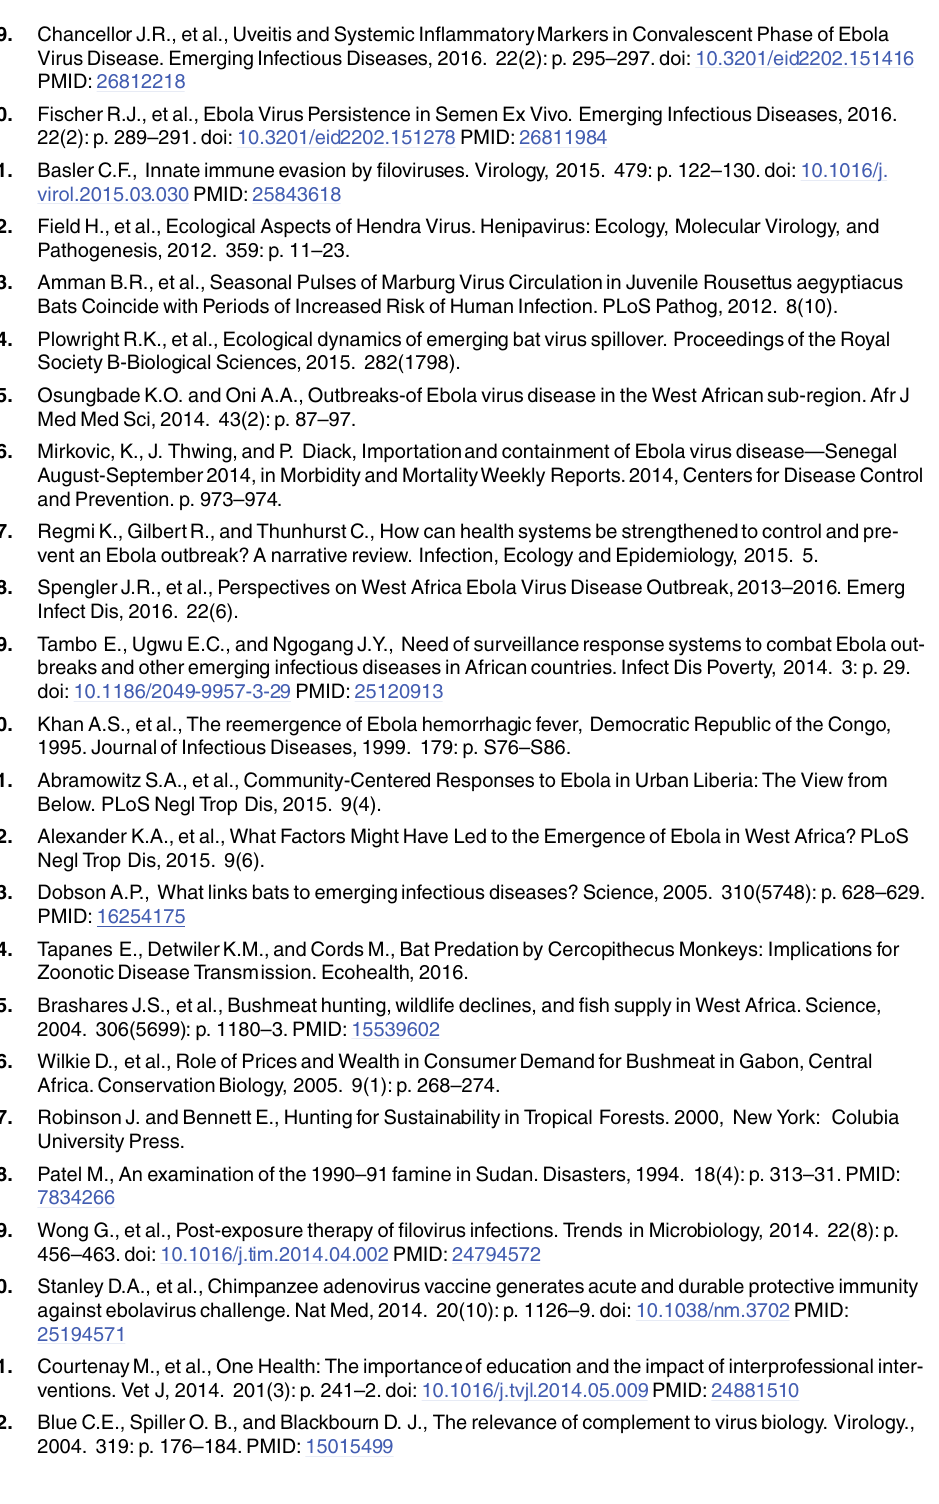
PLOS Pathogens | DOI:10.1371/journal.ppat.1005731 September 15,